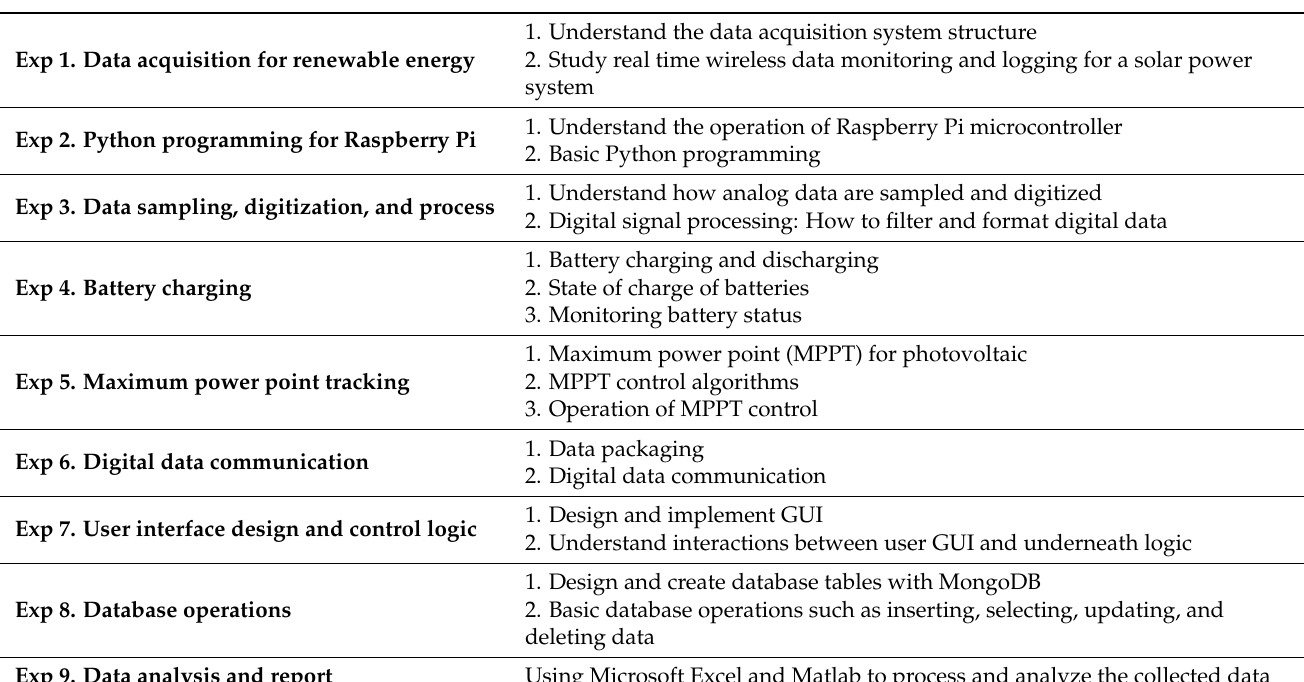
Table 2. Experiment Learning